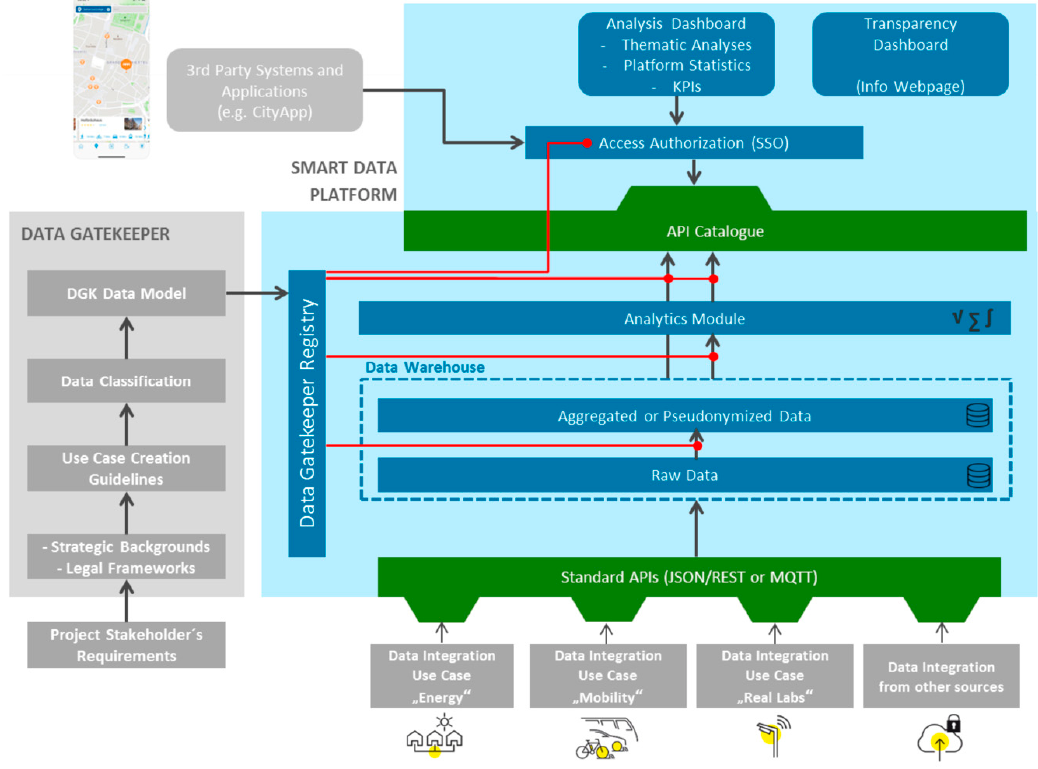
Figure 2. Overview of Munich’s data gatekeeper registry to SDP [20].